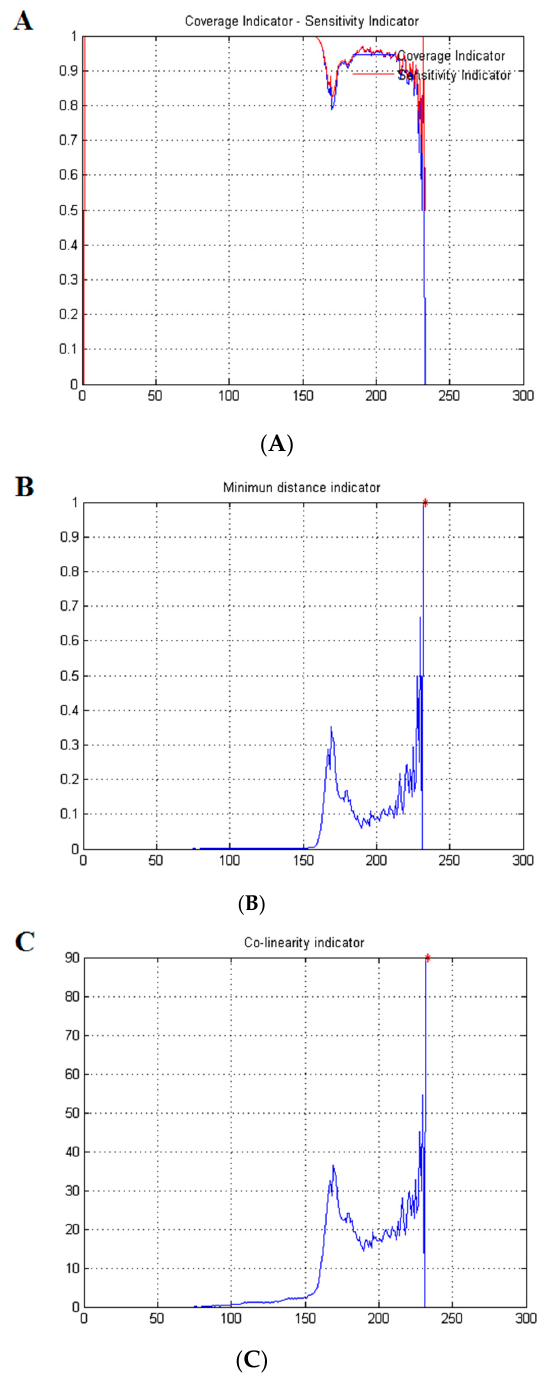
Figure 8. Similarity indexes from Image A5 in Figure 9: ( A ) sensitivity and coverage index; ( B ) minimum distance index; ( C ) co-linearity index. The best threshold is given by the local minimum or maxima located around t = 170.